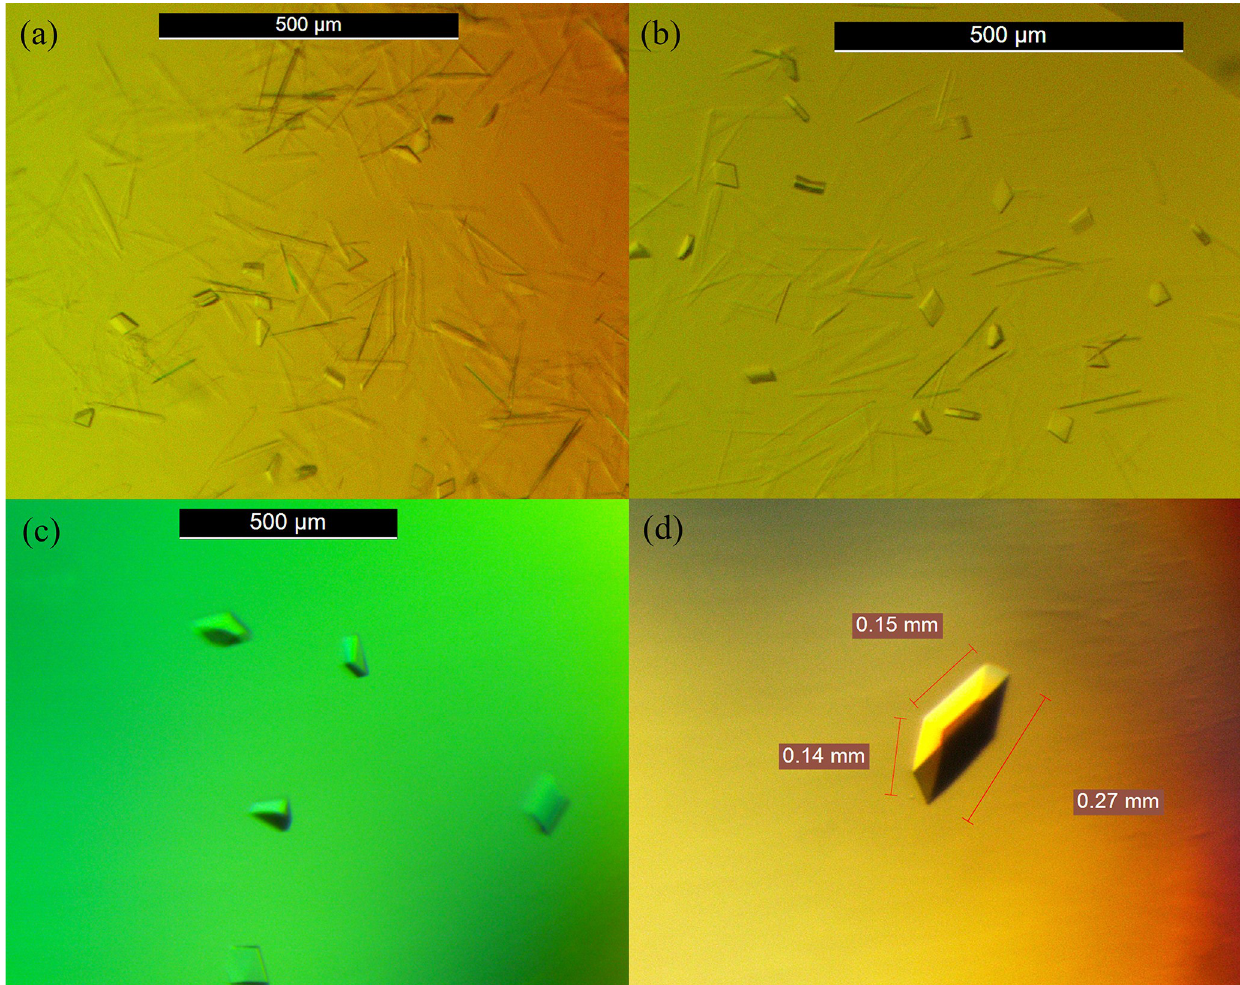
Fig 2. 5M mutant crystals. (a) Crystal of 5M mutant observed after one week of incubation during crystal screening with protein concentration of 5 mg/mL. (b) Crystal observed in the optimized formulation of 0.5 M sodium cacodylate pH 6.5, 0.4 M sodium citrate tribasic dehydrate with a protein concentration of 5 mg/mL. (c) The morphology of the crystal improved after the optimization of protein concentration. The best concentration was at 2.5 mg/mL. (d) Good morphology and shape of the crystal obtained after the addition of salt. Crystal obtained at a concentration of 0.2 M sodium chloride.